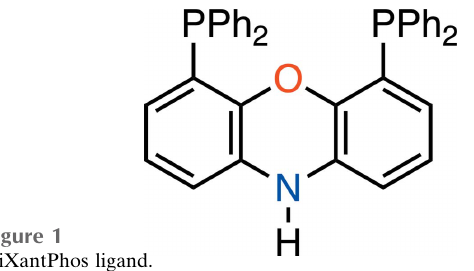
Figure 1 NiXantPhos